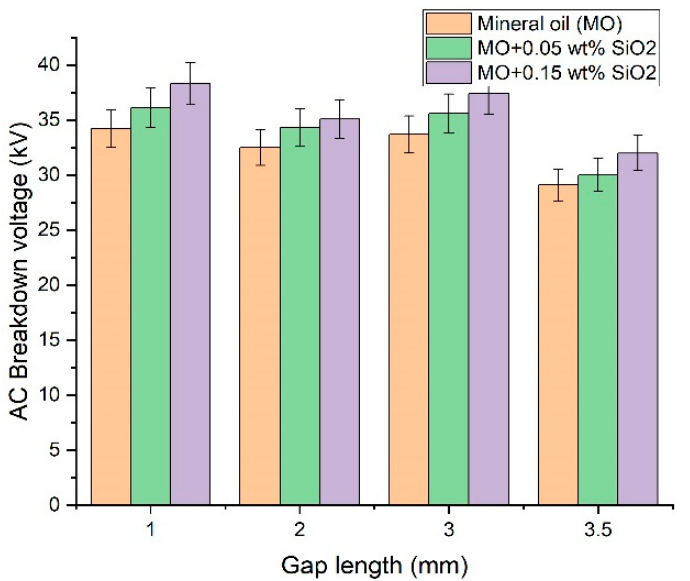
Figure 8. Graph showing the variation of breakdown voltage of mineral oil and its nanofluids with SLV (90%).